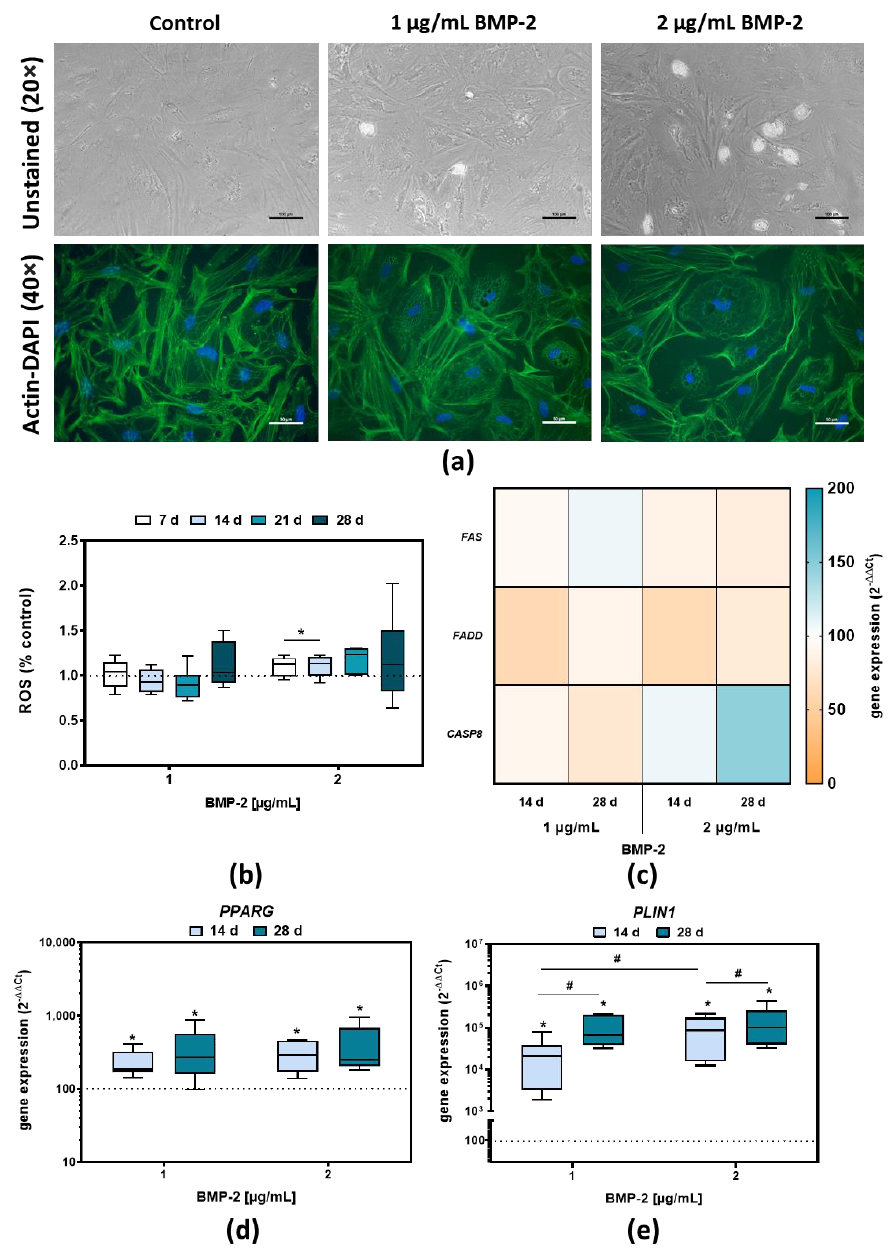
Figure 4. Long-term effect of BMP-2 exposure in human pre-osteoblasts. ( a ) Unstained microscopic images (bar: 100 µ m) and actin-DAPI-stained images (bar: 50 µ m) after BMP-2 exposure for 28 days with 1 or 2 µ g/mL; ( b ) Reactive oxygen species (ROS) quantification after 7-, 14-, 21-, or 28-days following BMP-2 treatment with 1 or 2 µ g/mL. The data are depicted relative to the control values and are shown as medians, interquartile ranges, minimum, and maximum (n ≥ 6). ( c ) Gene 14 or 28 days. The data are depicted as 2 ( − ∆∆ Ct) values (n ≥ 7). ( d , e ) Gene expression analyses